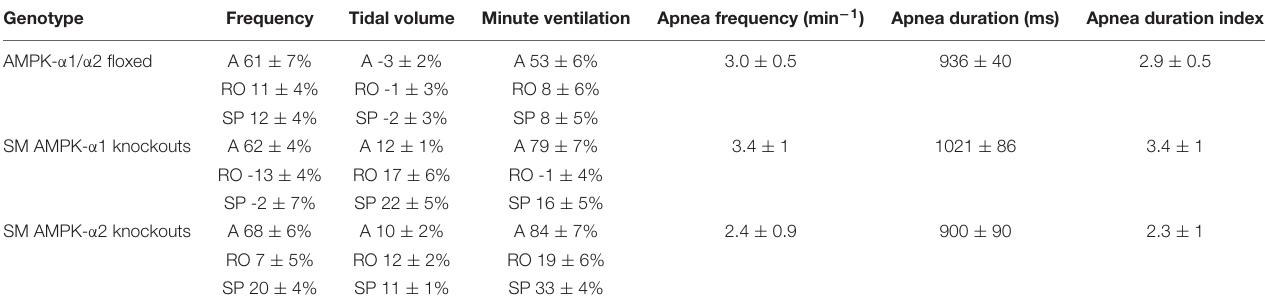
TABLE 1 | Means ± SEM of percentage changes in breathing frequency, tidal volume, and minute ventilation and values for apnea frequency, apnea duration and apnea duration index during exposures to hypoxia (8%O 2 ) across all genotypes.